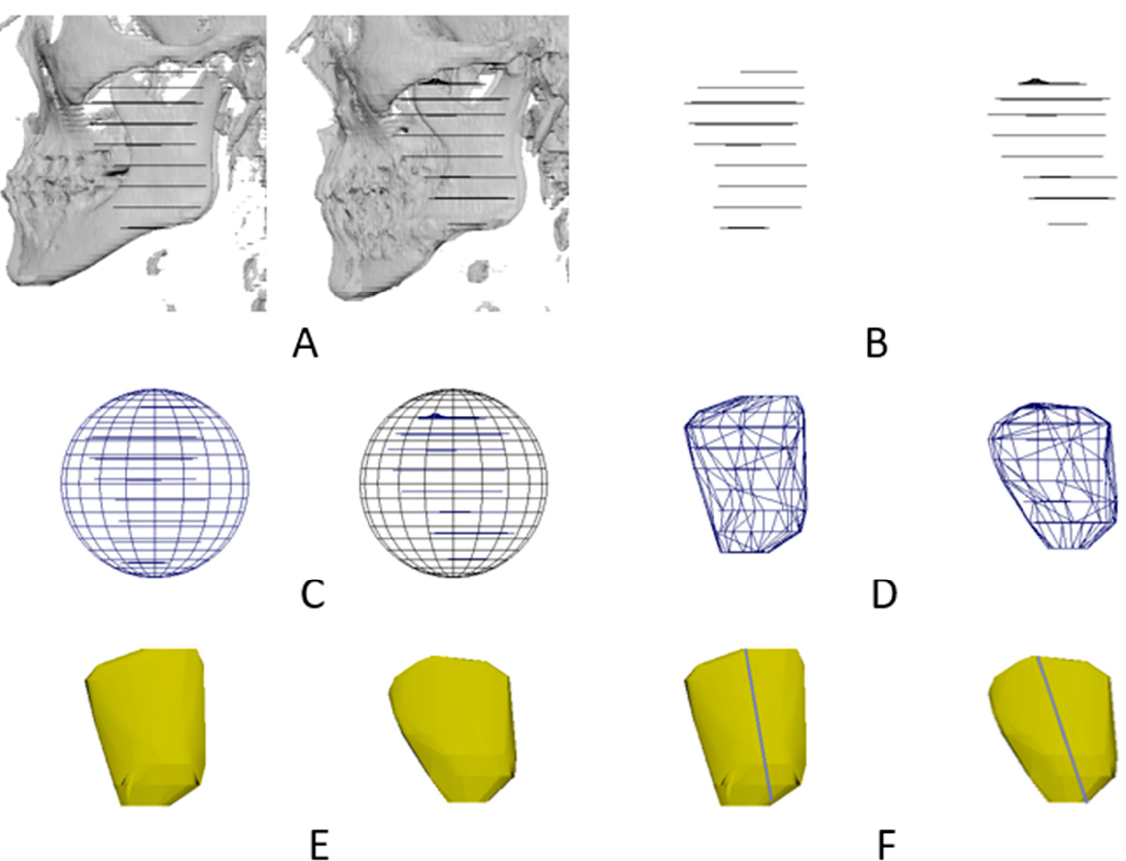
Figure 1. Surface reconstruction of a masseter muscle before ( left ) and after ( right ) a mandibular setback. The masseter muscle and skull were initially surface reconstructed. ( A ) Transparent skull revealing the initial surface models of the masseter muscle. ( B ) Initial surface models of the masseter muscle. ( C ) A polyhedron generated and ( D ) wrapped around the initial surface models of the masseter muscle. ( E ) Realistically and smoothly reconstructed surface model of the masseter muscle. ( F ) Length of the masseter muscle measured using a ruler.